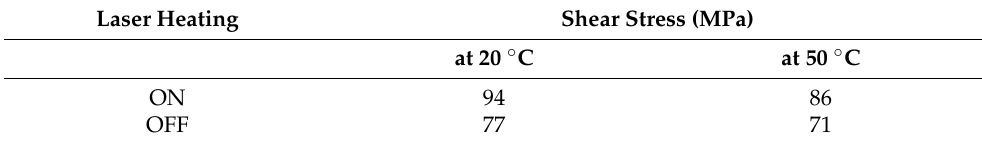
Table 9. Effect of laser heating during printing on shear stress of PLA + 2% graphite specimens. Laser